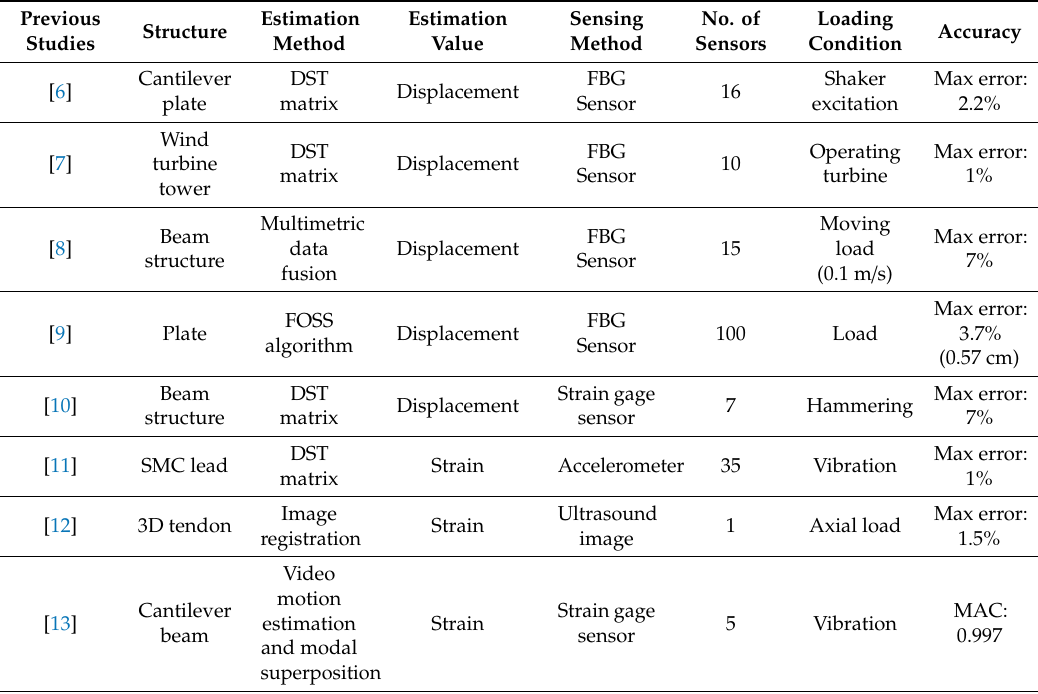
Table 1. Comparison of the deformation estimation